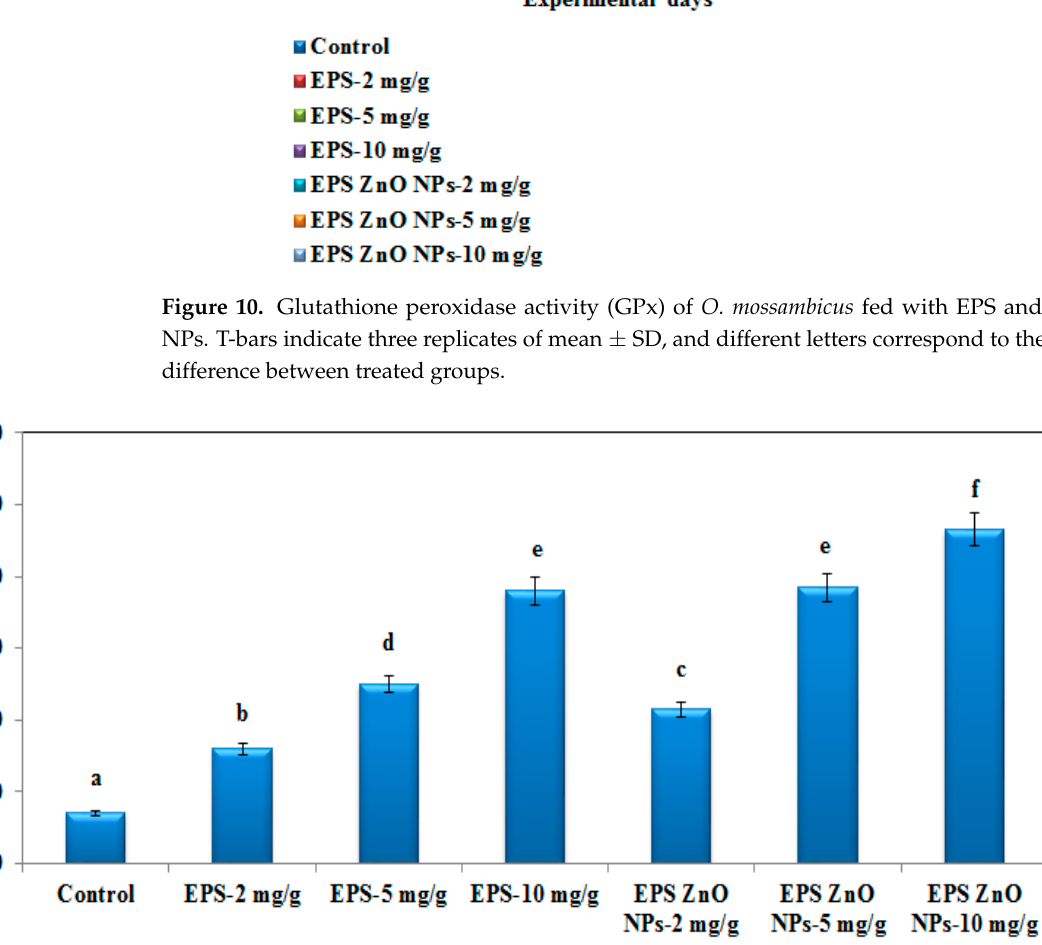
Figure 10. Glutathione peroxidase activity (GPx) of O. mossambicus fed with EPS and EPS-ZnO NPs. T-bars indicate three replicates of mean ± SD, and different letters correspond to the statistical dif- ference between treated groups.